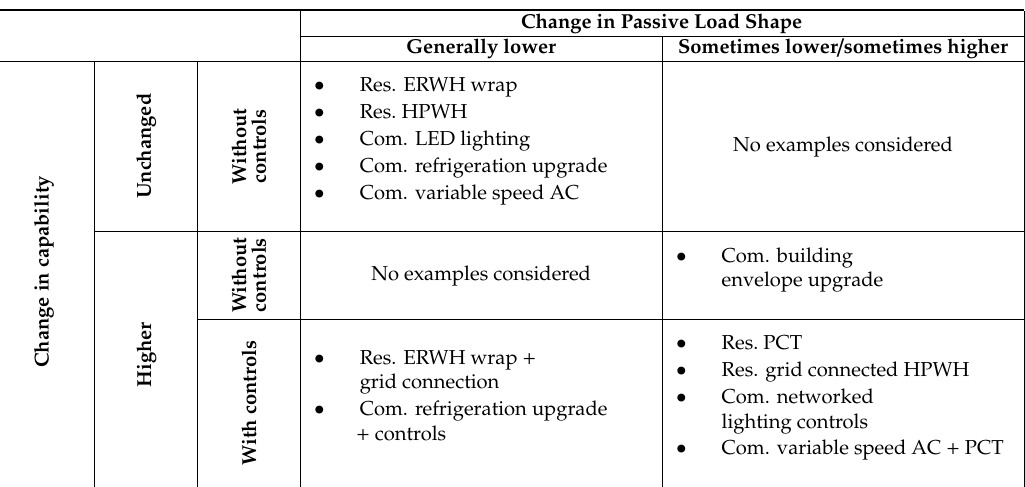
Table 4. Examples of change in passive load shape and change in capability for a building to provide demand flexibility (Level